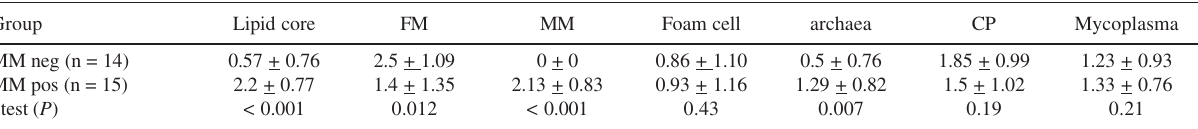
Table 1 - Mean and standard deviation of semiquantitative results Group Lipid core